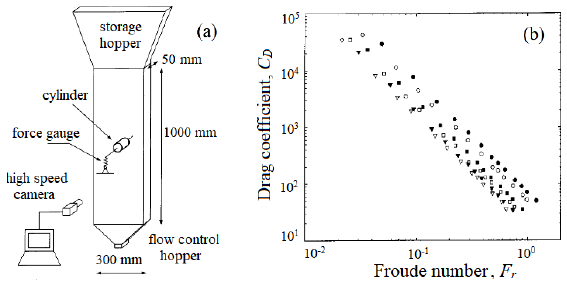
Fig. 5. (a)A schematic of the experimental apparatus; (b)The relationship between drag coefficient with Froude number